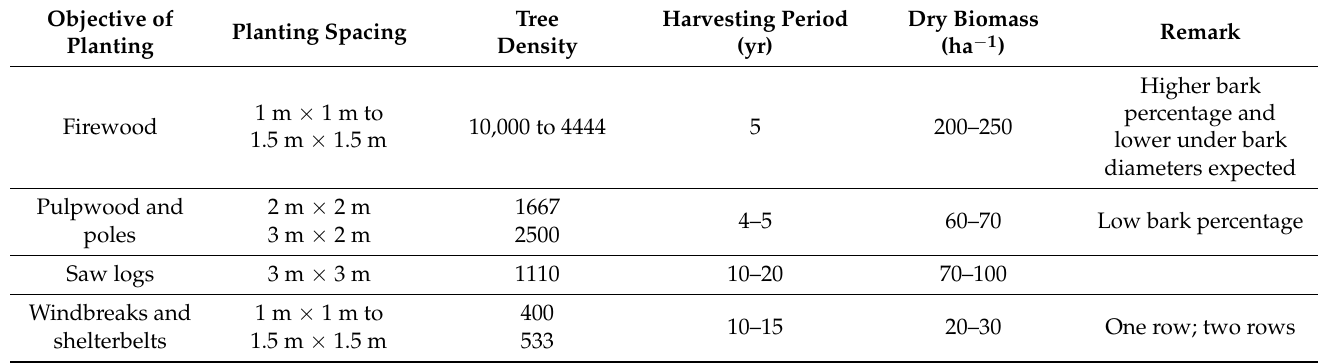
Table 7. Range of espacement for eucalyptus hybrid (adopted from Luna